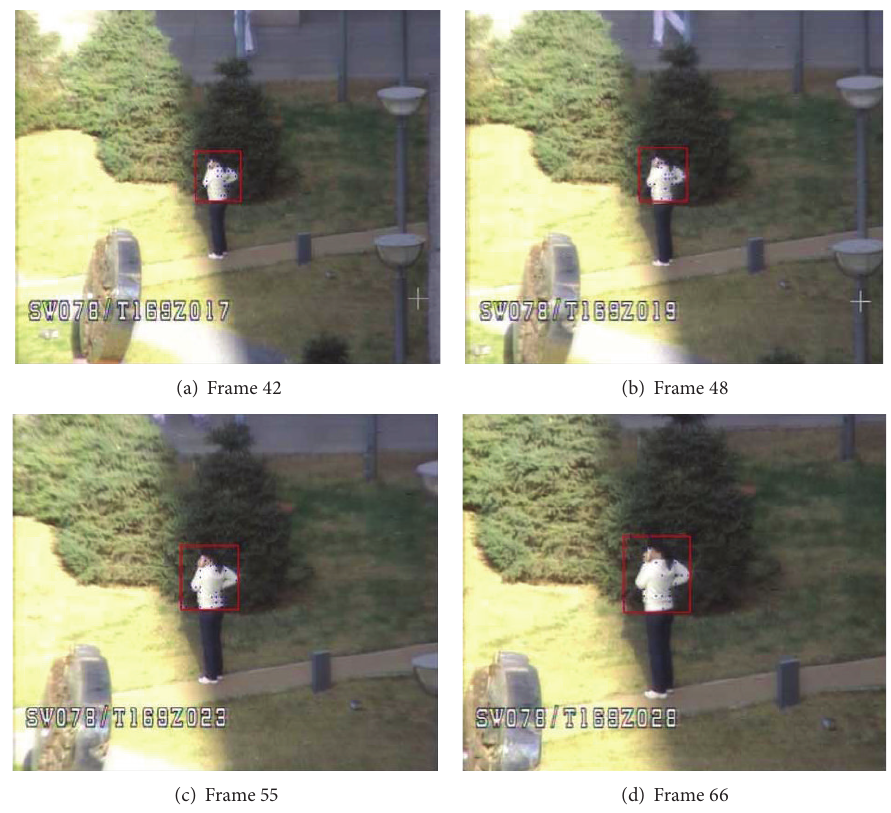
Figure 7: The control results from zoom = 7 to zoom =